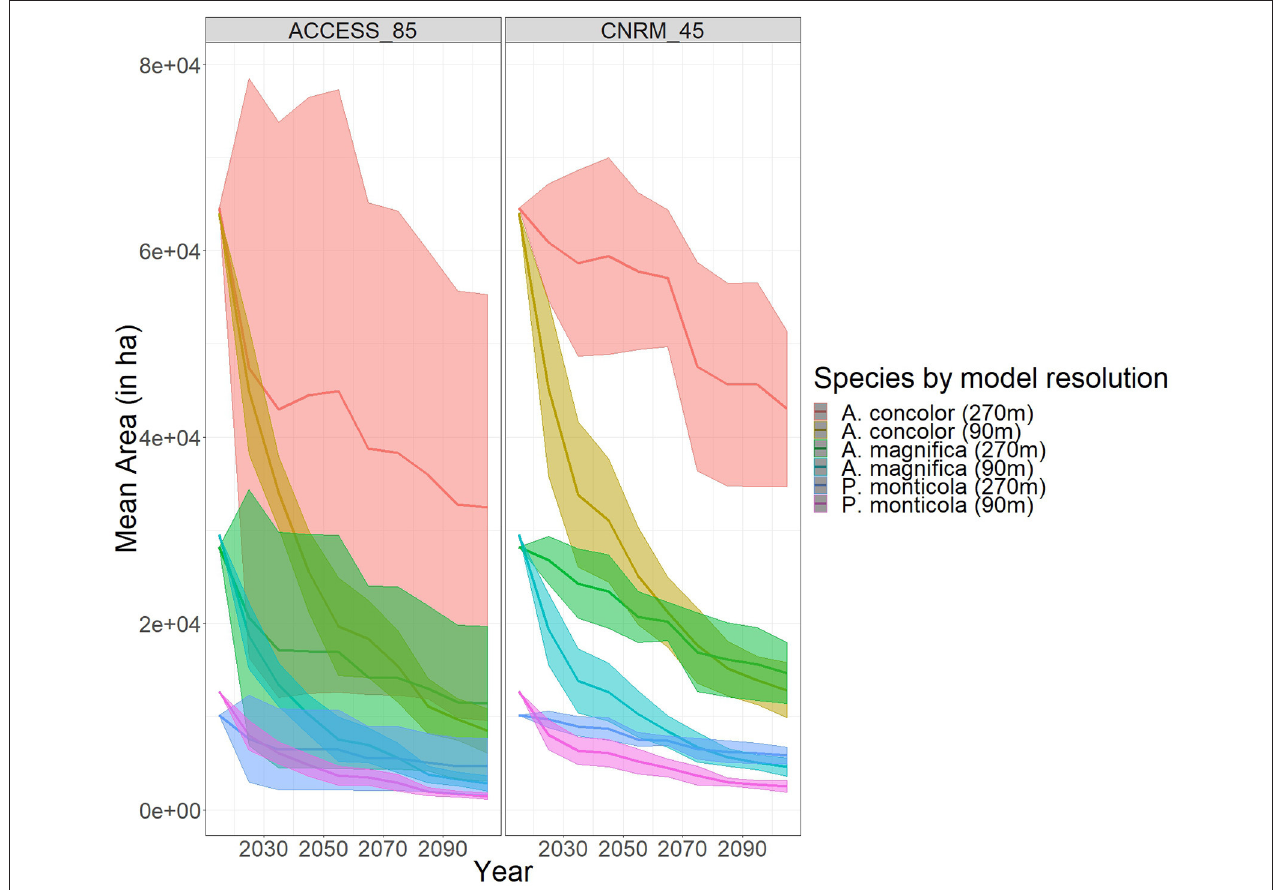
FIGURE 3 | Mean area, in hectares, occupied by specific conifer species, under different model resolutions and different climate change